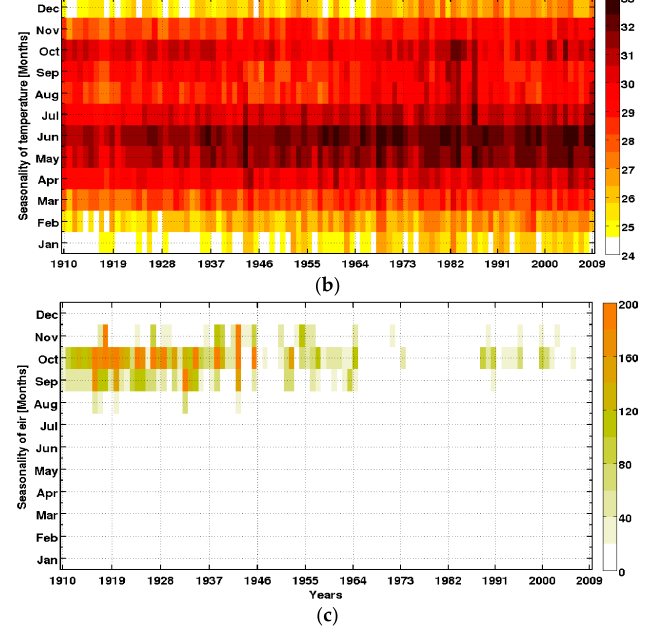
Figure 6. Intra- and interannual variability of climate parameters and the simulated malaria parameter: ( a ) rainfall (mm); ( b ) temperature ( ◦ C); and ( c ) simulated EIR (infectious mosquito bites per person per month), in Senegal